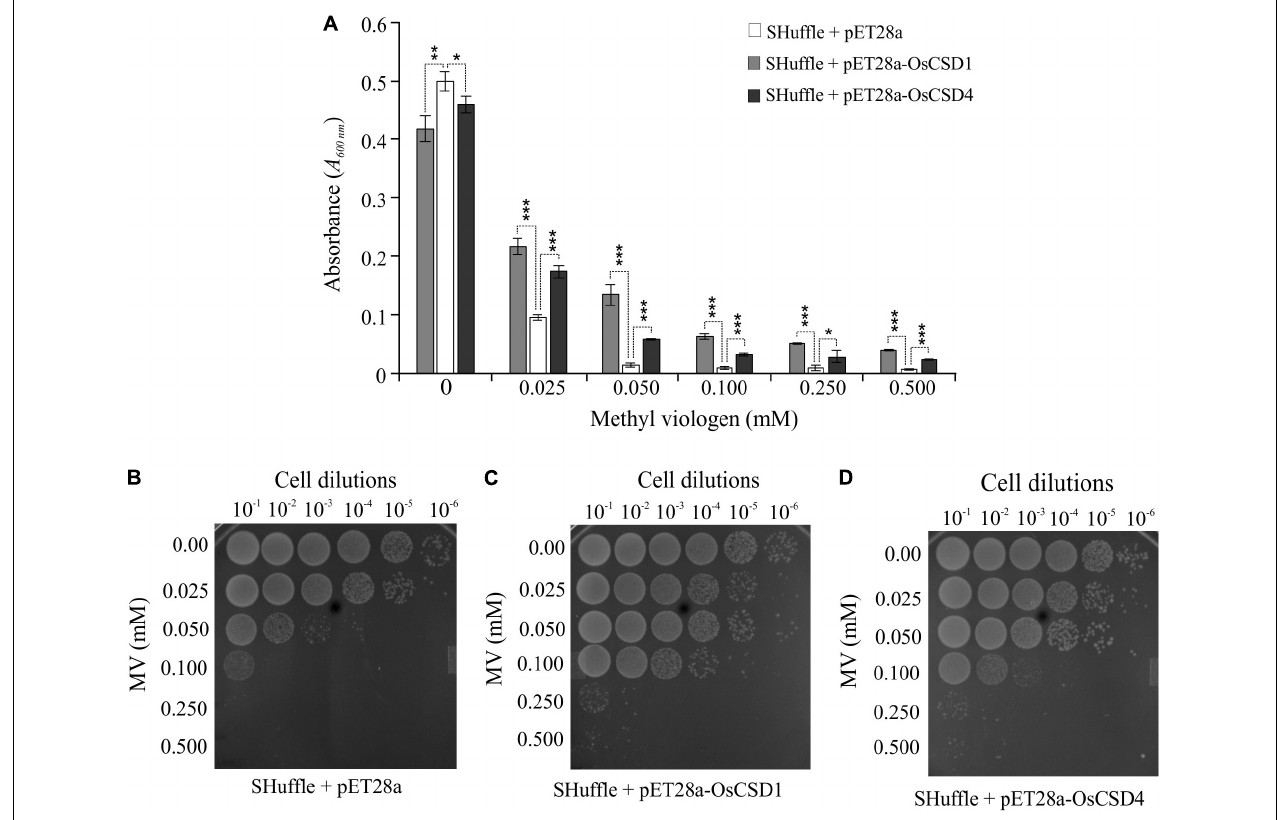
FIGURE 9 | Analysis of oxidative stress tolerance of E. coli SHuffle T7 Express cells overexpressing OsCSD1 and OsCSD4. (A) Comparative analysis of growth of E. coli cells (absorbance at 600 nm) containing pET28a (empty vector), pET28a-OsCSD1, and pET28a-OsCSD4 plasmids. Cells induced with IPTG were treated with increasing methyl viologen concentration (0–0.500 mM) and monitored spectrophotometrically. The experiment was repeated three times and data are represented as mean value ± SD. Statistical significance is indicated by * p < 0.05, ** p < 0.01, *** p < 0.001. (B–D) Spot test assay for evaluation of oxidative stress tolerance of E. coli SHuffle T7 Express cells containing empty pET28a (B) , pET28a-OsCSD1, (C) and pET28a-OsCSD4 (D). Cells were induced with IPTG, treated with methyl viologen (0.0–0.500 mM), and analyzed by spot test. The numbers on the top indicates the serial dilution of the E. coli